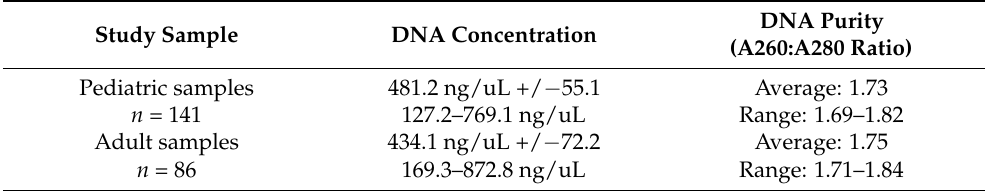
Table 3. Analysis of DNA from study samples.